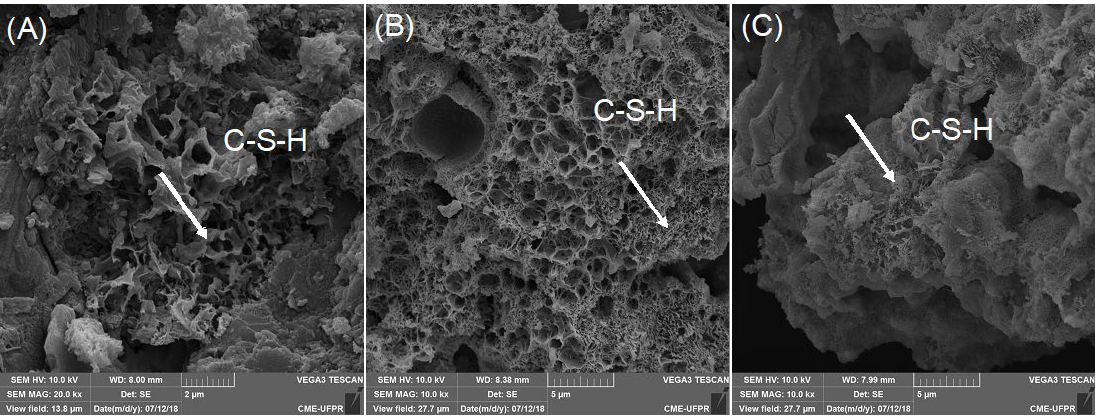
Figure 10. SEM of C-S-H (A) SF (B) RHA (C) Control.